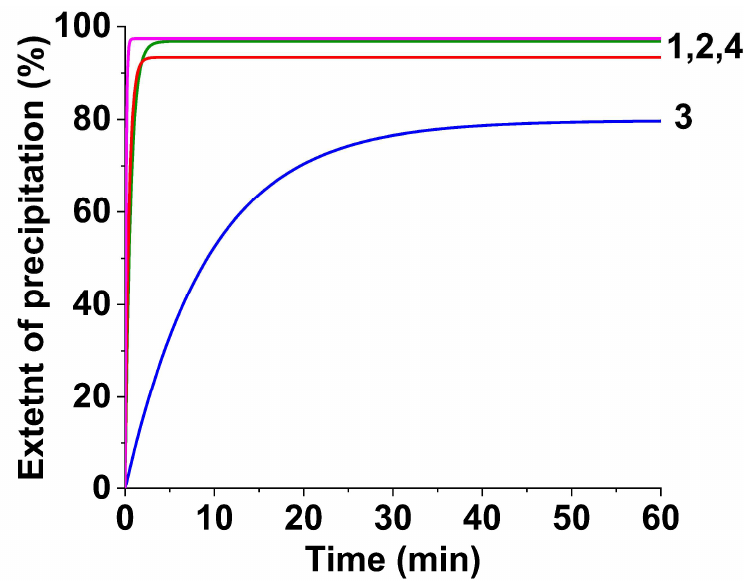
Figure 1. The extent of the precipitation of metals as a function of time: 1—obtained with dextran-40, 2—obtained with inulin, 3—obtained with dextran-70, 4—obtained without polysaccharides. The resulting anion-exchange precipitation products had an X-ray amorphous nature.